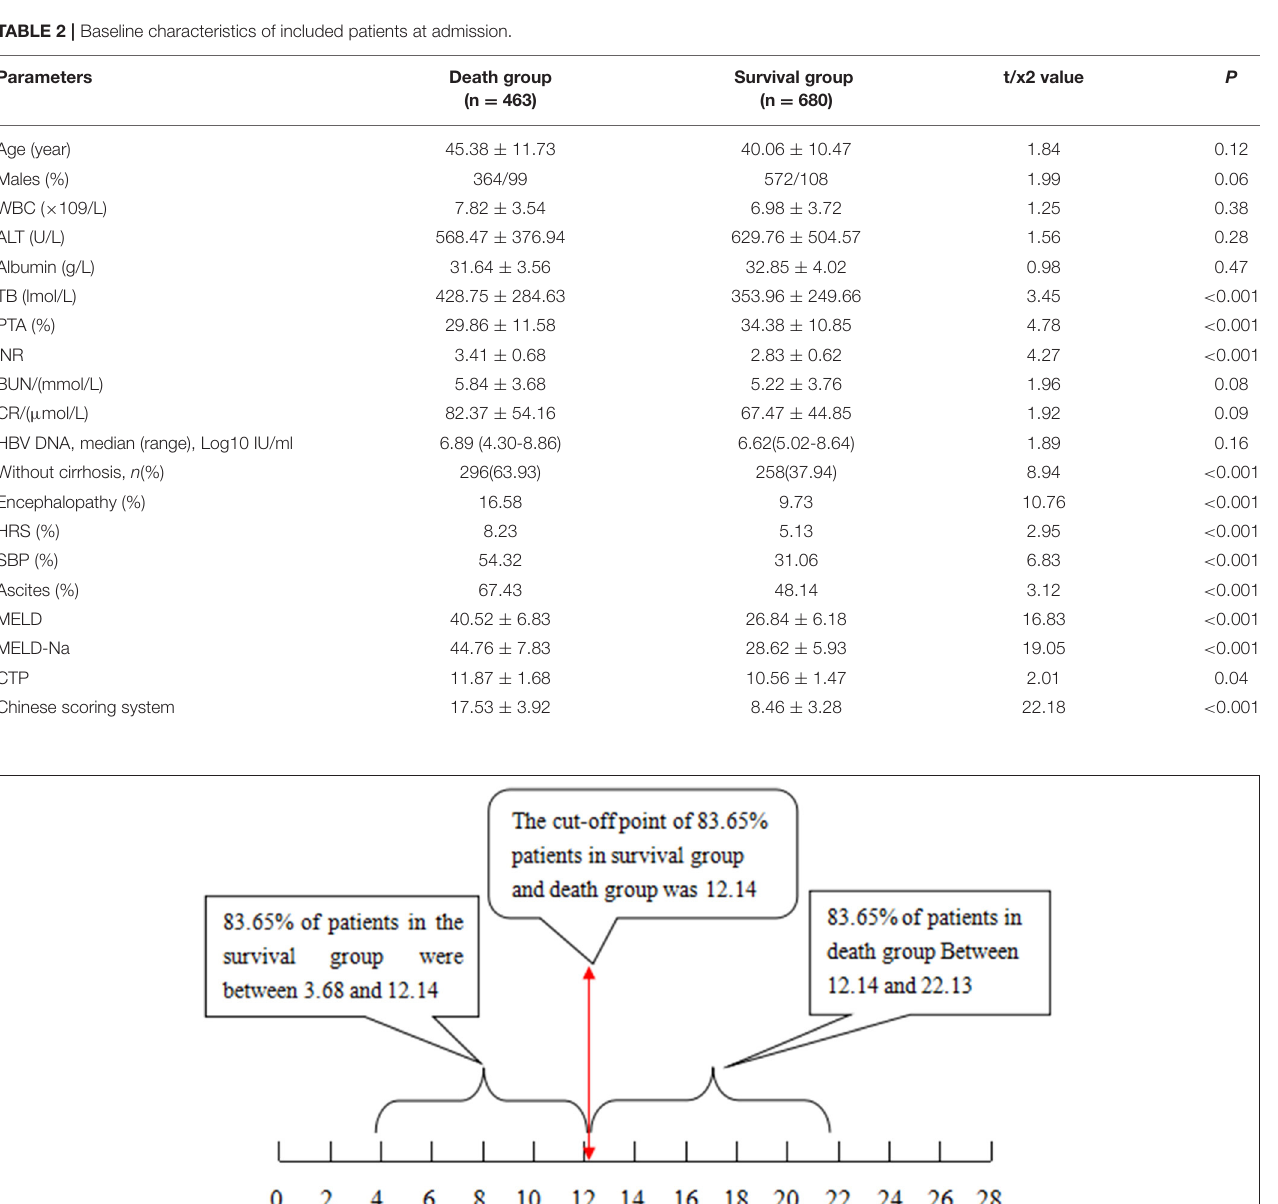
indicating less effectiveness than the Chinese score system (see Figure 3 and Table 3 ). The Ability to Predict and Differentiate Disease Outcomes at Different Times With Different Scoring Systems The predictive values for the outcomes on days 30, 90, and 180 after discharge using the Chinese scoring system were 0.764